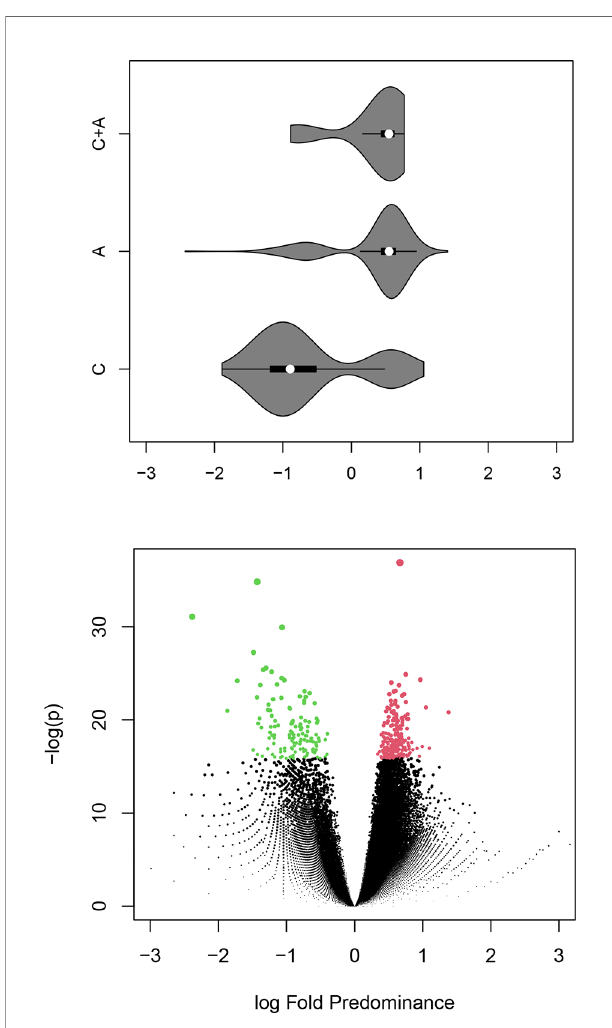
FIGURE 6 | Bellow – volcano plot illustrating the differential representation of control or APS speci fi c mimotope sequences in each (overlapping) neighborhood of the graph. After a Benjamini-Hochberg false discovery rate correction the signi fi cant 358 neighborhoods (red – A or green - C ) contained 38% with predominance of C sequences while the percentage of C sequences in the library is 26%. Above – a violin plot corresponding to the fold difference on the X axis of the volcano plot showing the distribution of the central sequence for each neighborhood by group. The colors indicate the type of neighborhood. APS – anti-phospholipid syndrome.